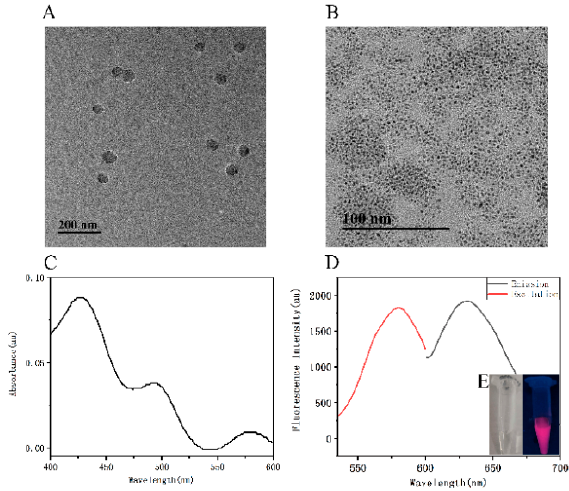
Figure 4. Transmission electron microscopy (TEM) image of C6G5C6-apt-AgNCs ( A ) and PPyNPs ( B ). ( C ) UV–visible light (UV–Vis) absorption spectrum of the C6G5C6-apt-AgNCs. ( D ) The FI spectra of the excitation spectrum (red curve) and emission spectrum (black curve) of the C6G5C6-apt-AgNCs. Inset: the images of a C6G5C6-apt-AgNCs solution acquired under daylight (left) and UV light (right).